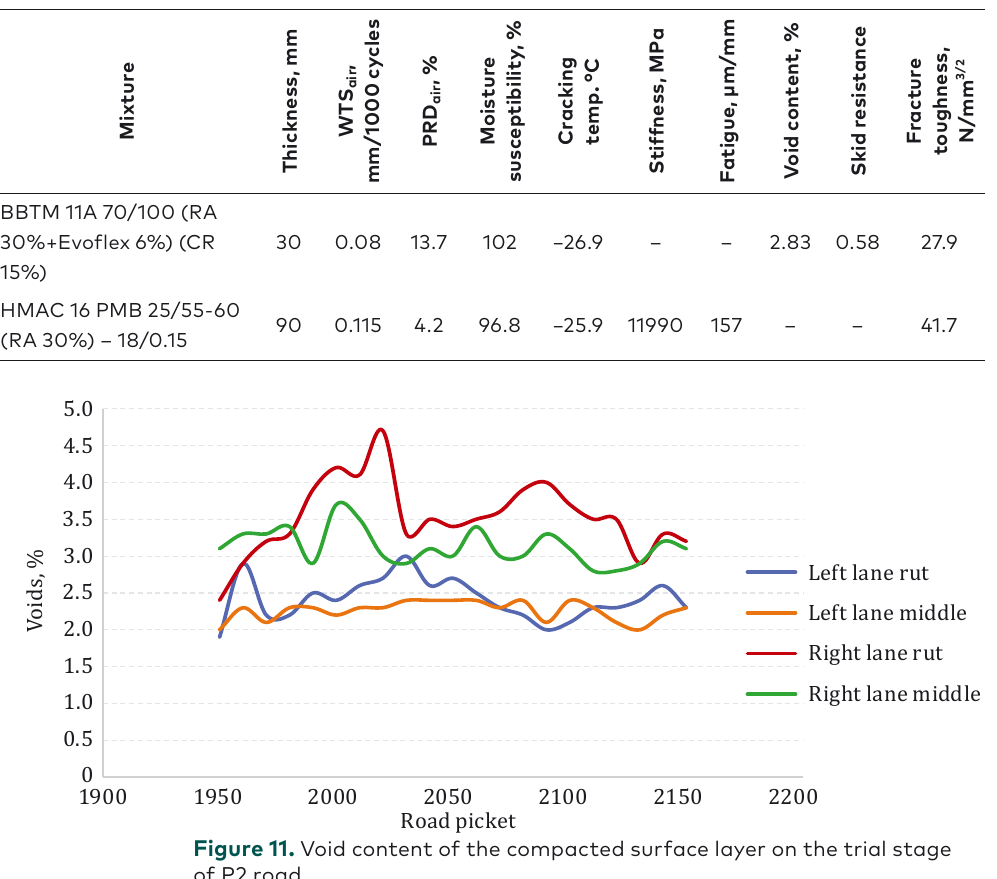
Figure 11. Void content of the compacted surface layer on the trial stage of P2